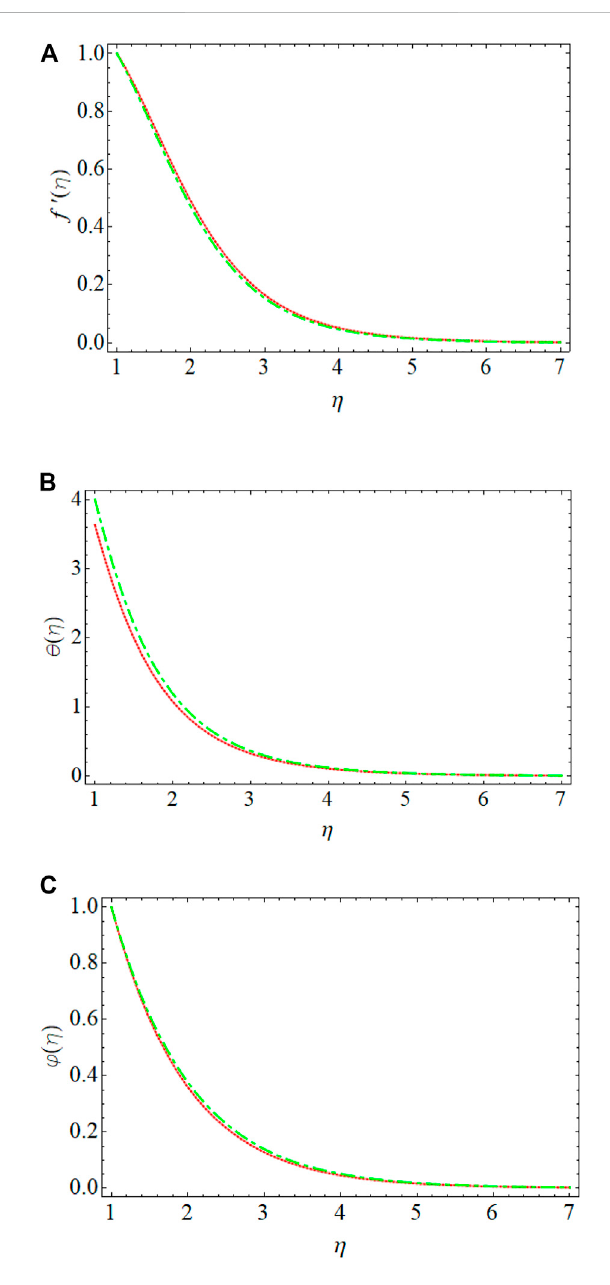
FIGURE 7 (A – C) Validation of the current work with established